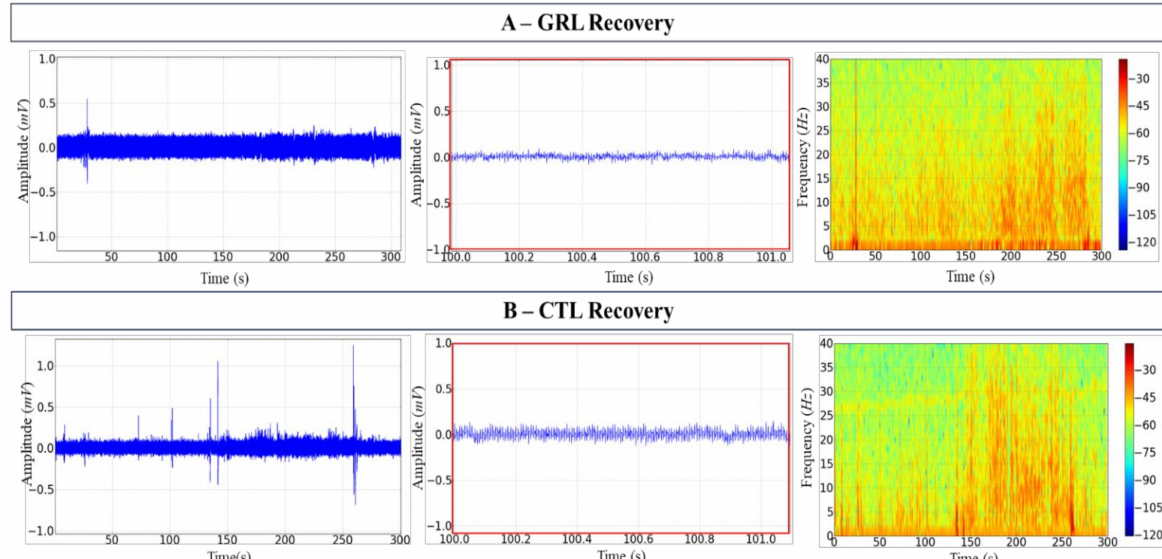
Figure 3. Electroencephalographic (EEG) recordings of the tambaqui C. macropomum midbrain during recovery. ( A ) Geraniol (GRL) records over 300 s (left); 1 s snapshot amplification (centre); the spectrogram of frequency showing the distribution of power (right). ( B ) Citronellol (CTL) records over 300 s (left); 1 s snapshot amplification (centre); the spectrogram of frequency showing the distribution of power (right). Amplification of 5000 × . Records from one fish only in each